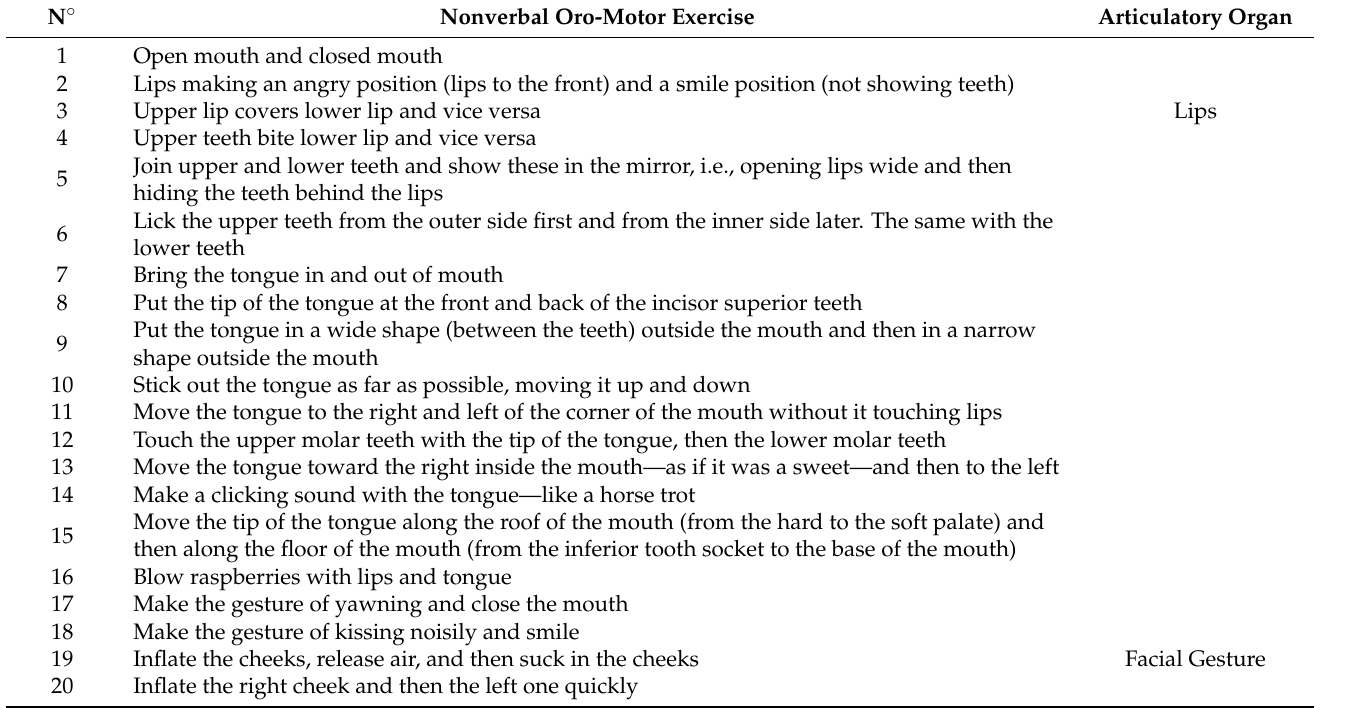
Table 2. Nonverbal oro-motor exercises selected for